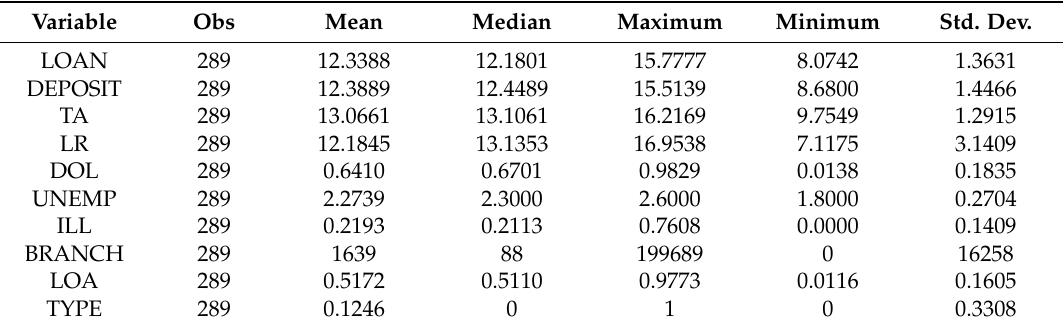
Table 2. Descriptive statistics of the